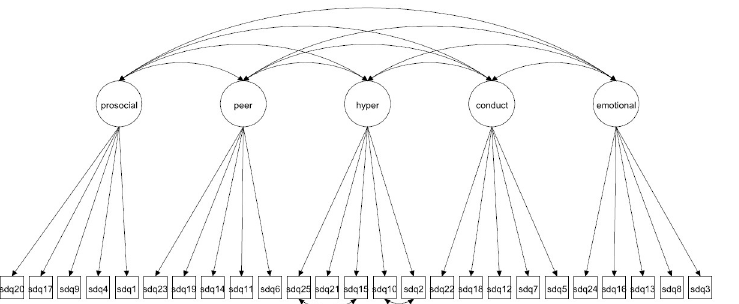
Fig 13. 5-factor model with correlated errors for minor factors (Model 7).